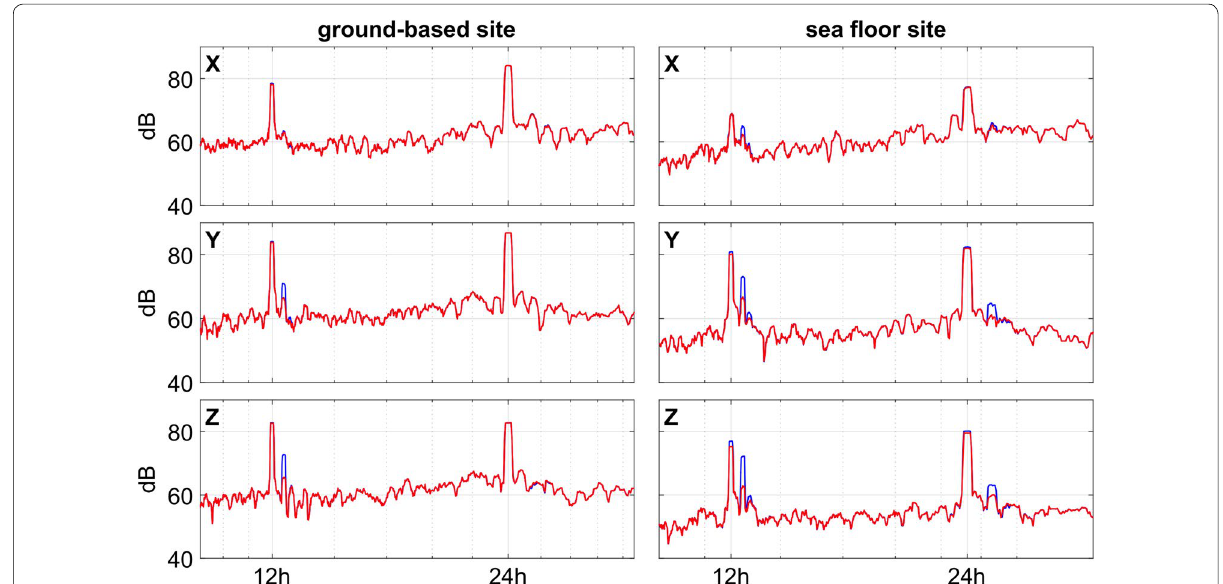
Fig. 17 Power spectral density (PSD) plots at VAL (Ireland, ground) for the year 2011 and T12-2 (Philippine Sea; sea floor) for the year 2007. PSD of observed (blue) and corrected (red) data are